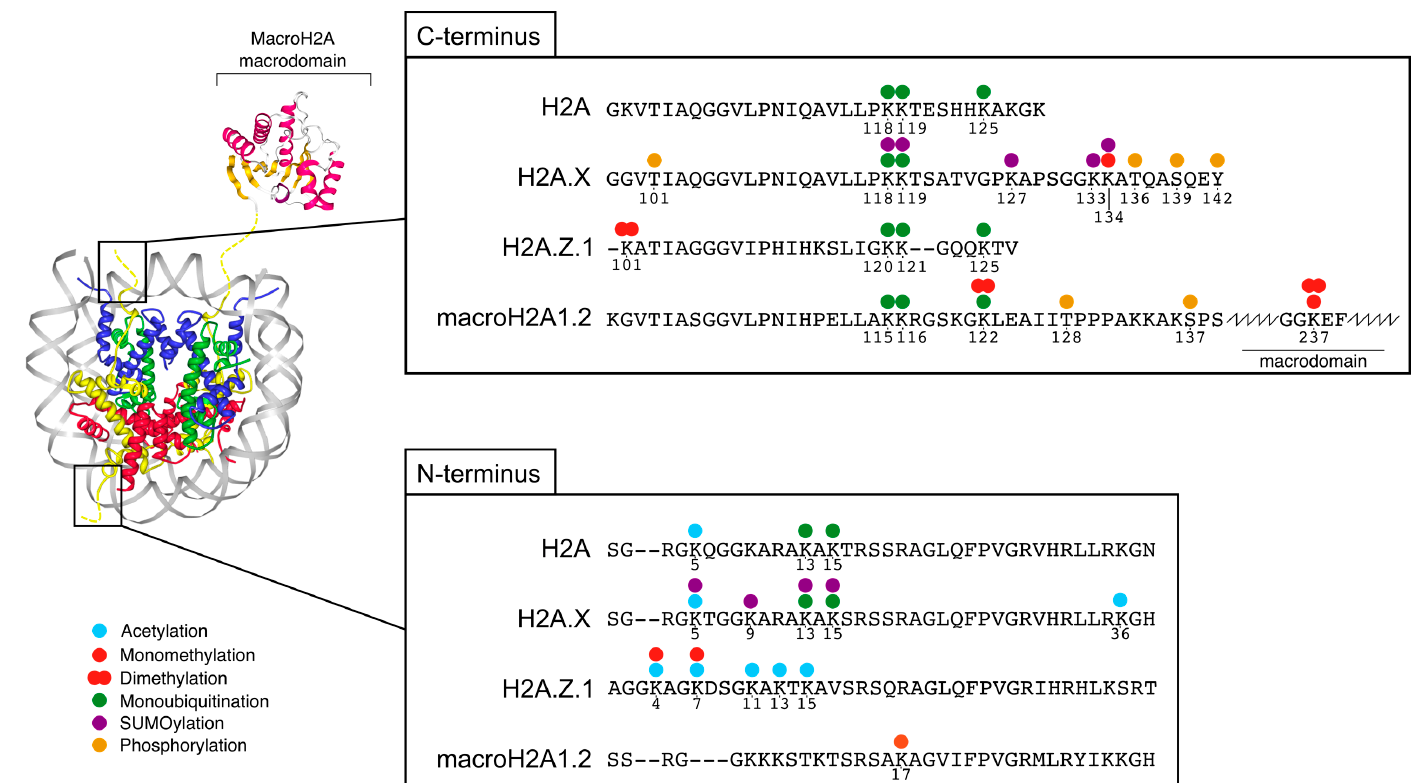
Figure 1. Amino acid sequence of the N- and C-termini of human H2A variants and their post-translational modifications. Alignment of human H2A type 1 (NCBI ID accession number NP_003501.1), H2A.X (NP_002906.1), H2A.Z.1 (NP_002907.1) and macroH2A1.2 (NP_004884.1). The crystal structure of a nucleosome containing a macroH2A histone is depicted. Histone H2A is colored in yellow, H2B in red, H3 in blue, H4 in green and DNA in grey. Dashed lines represent the H2A tails. The macrodomain of macroH2A is colored by secondary structure ( α -helices in magenta and β -sheets in orange). The picture of the nucleosome is based on protein data bank ID 3REH [20] and generated with ProteinWorkshop [21], the picture of the macroH2A macrodomain is based on PDB ID 2FXK [22] and generated with NGL viewer [23,24].